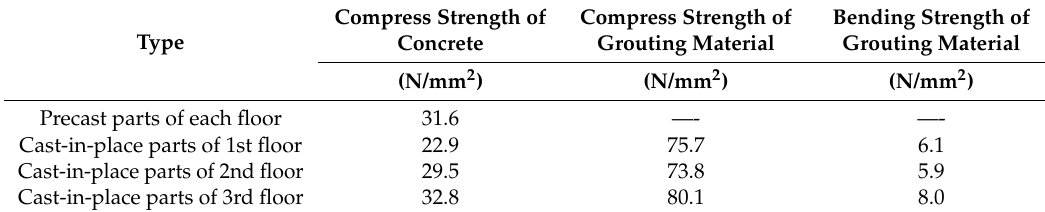
Table 2. Material properties of the concrete.